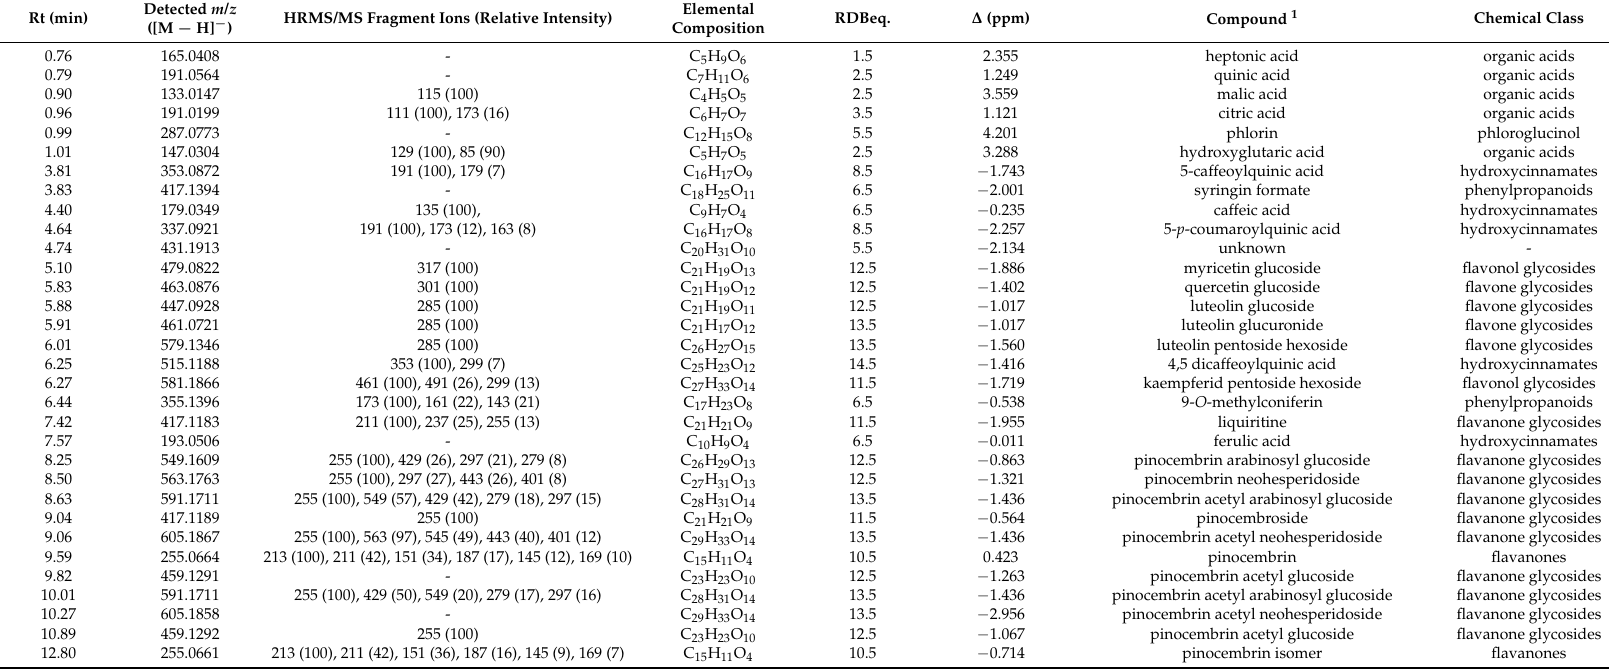
Table 1. Retention time (Rt), HRMS data, and proposed identification of detected features in Centaurea raphanina enriched water decoctions by UHPLC-ESI( − )-HRMS. Rt